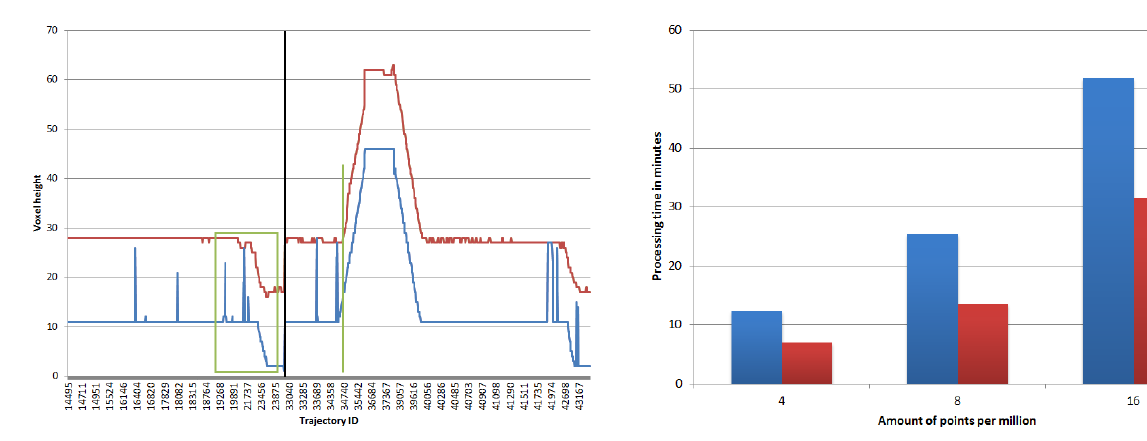
Figure 11. Processing time: blue is the total amount of time and red is the time which was necessary for the voxelization cannot be detected behind these objects. This results in a lower amount of navigable space in the final model than it is in